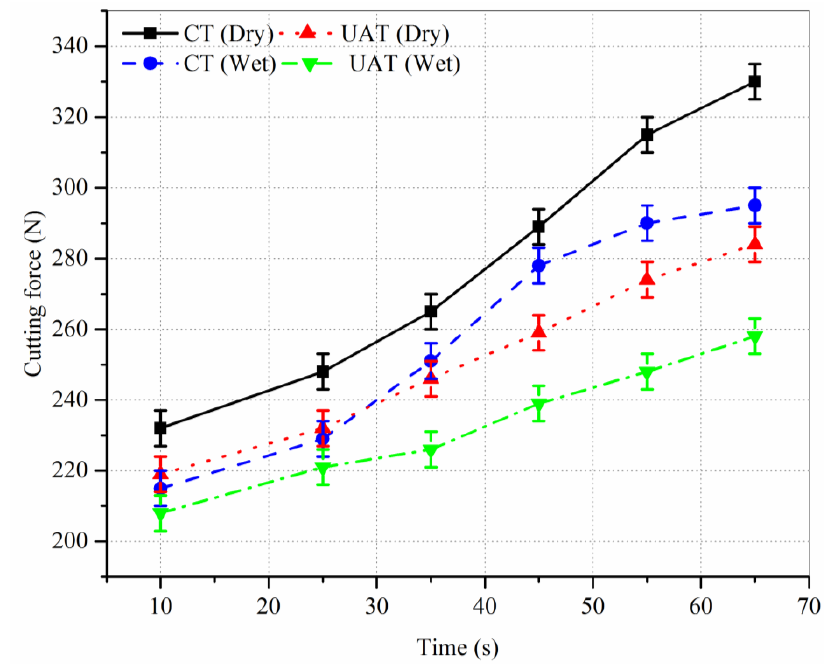
Figure 2. Variation in cutting force with time in CT and UAT under dry and wet conditions ( 𝑉 = 50 m/min, 𝑓 = 0.2 mm/rev, 𝑎 = 0.4 mm). ( V = 50 m/min, f = 0.2 mm/rev, a = 0.4